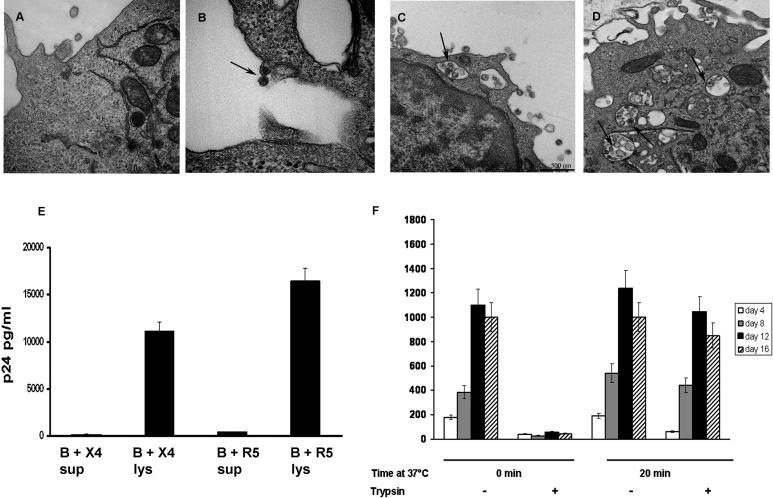
HIV-1 Is Internalized in B Cells(A–D) Transmission electron microscopy of HIV-1–loaded, activated B cells and DC. Activated B cells were left untreated (panel A) or loaded with AT-2–inactivated HIV-1 X4 (MN) for 1 h at 4 °C (panel B) or at 37 °C for 2 h (panel C). Immature DC (panel D) that were loaded with the same preparation of HIV-1 and incubated at 37 °C for 2 h were used as controls. Arrows indicate viral particles that have been internalized in cytoplasmic vesicles.(E) HIV-1 p24 levels in post-trypsin treatment supernatants (sup) and cell pellets of activated B cells (lys) that had been incubated with AT-2–inactivated HIV-1 X4 (MN) or HIV-1 R5 (Ba-L) for 2 h at 37 °C, and then incubated with 0.25% trypsin solution for 10 min at 37 °C. Controls included activated B cells without virus, which were negative for p24 (unpublished data).(F) Activated B cells were incubated with HIV-1 R5 (Ba-L) on wet ice, then washed and shifted at 37 °C for the times indicated. Cells were then treated with trypsin or mock treated and added to T cells. Supernatants were collected every 4 d and tested for p24. Data are from single experiments representative of three independent experiments.